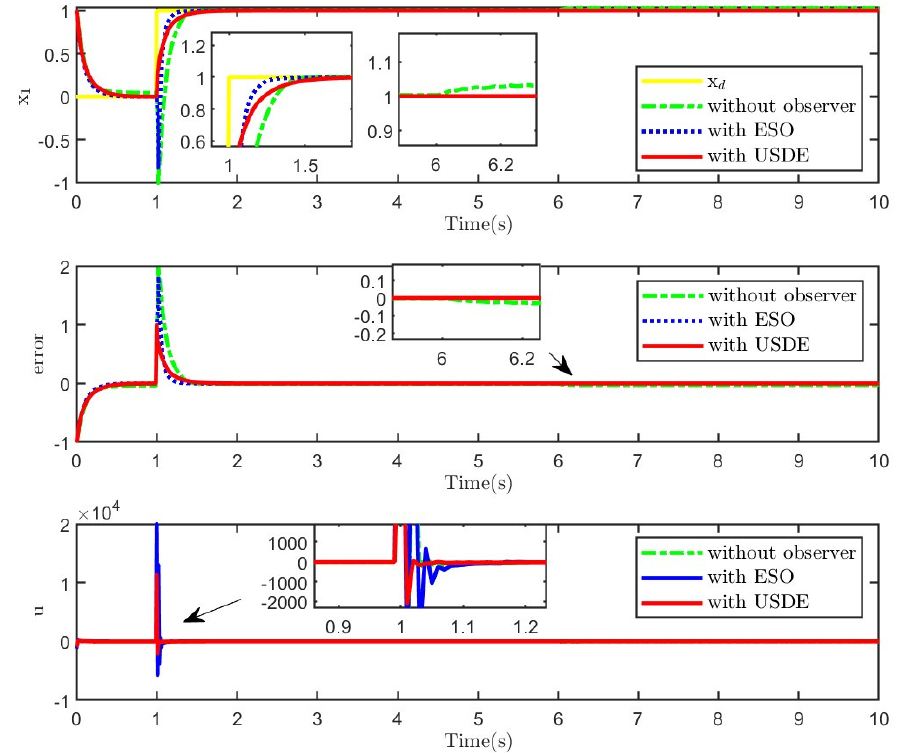
Figure 9. Tracking results of the system with mismatched uncertainty under the step signal.